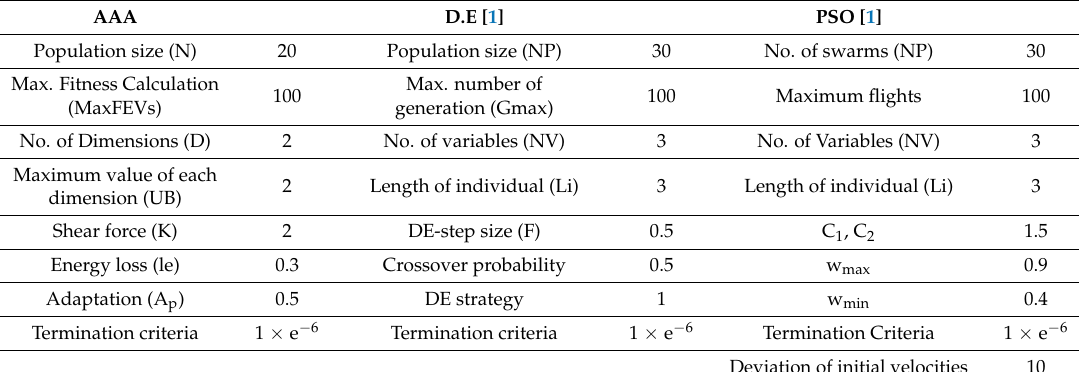
Table 2. Parameters settings of AAA, D.E and PSO algorithms.